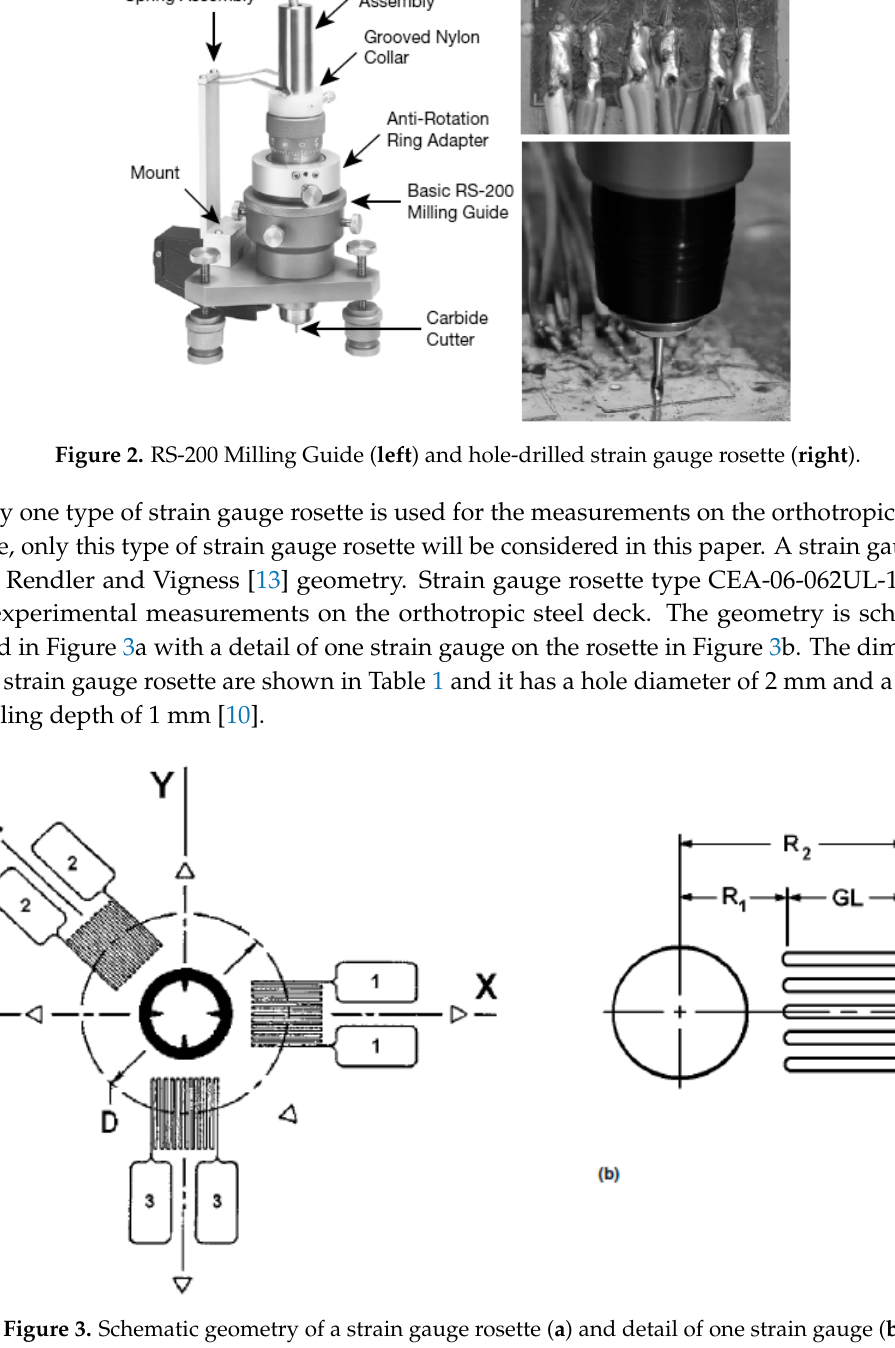
Figure 3. Schematic geometry of a strain gauge rosette ( a ) and detail of one strain gauge ( b ).